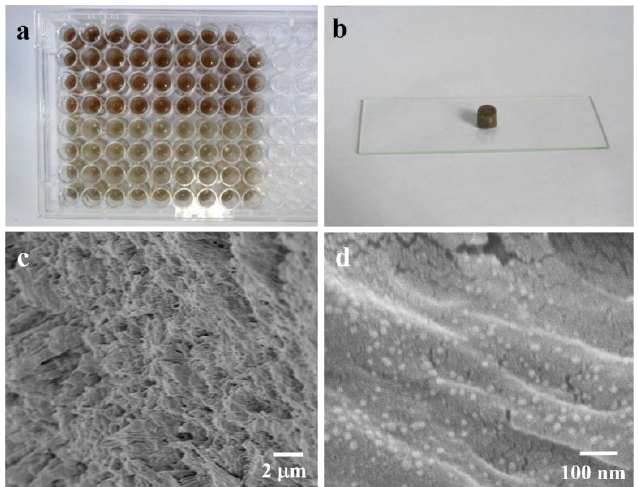
Figure 1. Characterization of the β-CD-Ag/PVA substrate. ( a ) Photograph of the β-CD-Ag/PVA sol before hydrogel formation; ( b ) Photograph of the β-CD-Ag/PVA hydrogel; ( c , d ) SEM images of the β-CD-Ag/PVA hydrogel at different magnification.